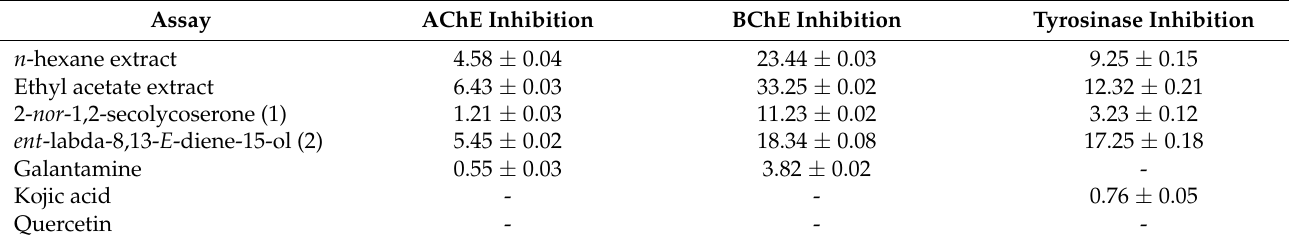
Table 3. Enzymatic inhibitory activity (IC 50 , in µ g/mL) of G. pinifolium .